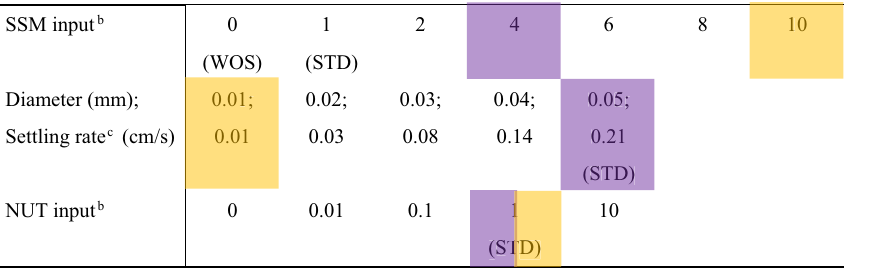
Table 1. Parameters for the sensitivity experiments a . Purple denotes the parameter combination in which the typical hypopycnal situation occurs; yellow indicates the parameters for the typical hyperpycnal situation. a Three parameters are varied in each experiment except for the WOS (without SSM) case. WOS changes only with nutrient input, so there is a total of 155 experimental cases. b Units of the inputs are normalized by the STD (Standard case) input. The input ranges of SSM and nutrients are determined on the basis of reasonable values for actual river systems 16, 17 . c Settling speeds are estimated from Rubey (1933) 18 , using the diameters and composition (2650 kg/m 3